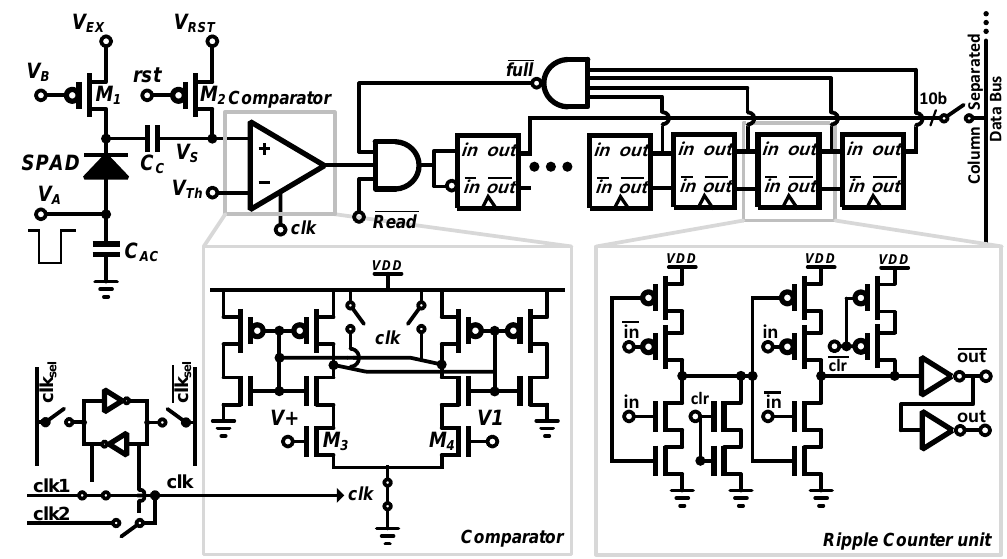
Figure 4. Pixel level schematic of